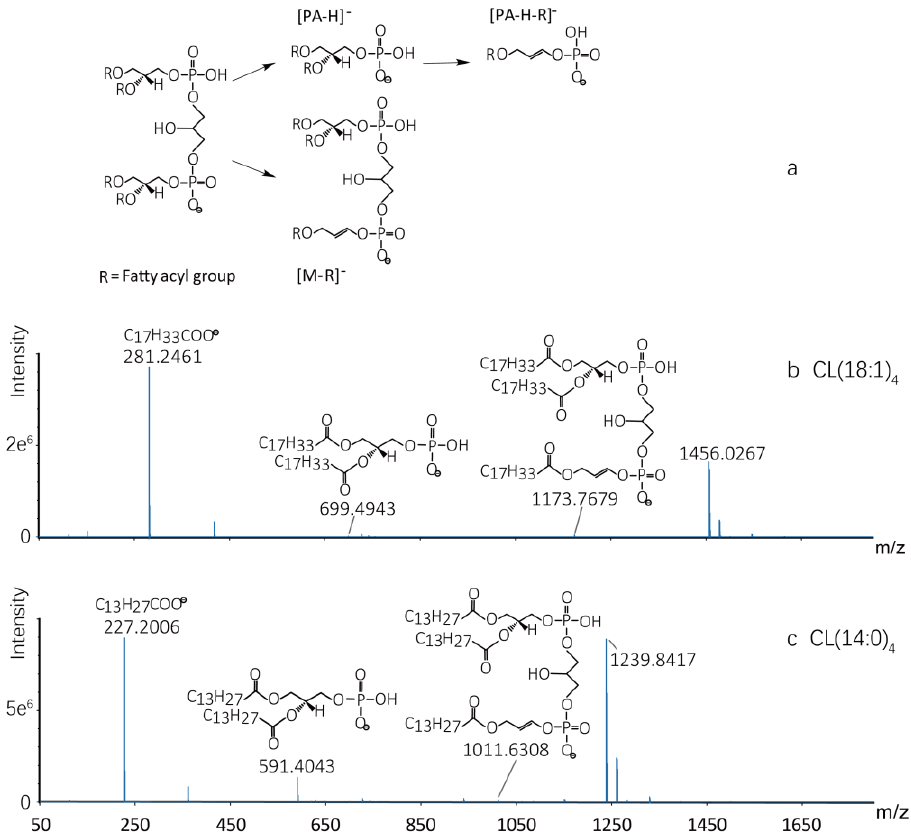
Figure 1. The chemical structure and characteristic product ions of CLs. ( a ) The chemical structures of CLs, consisting of two phospholipid groups, three glycerol groups and four fatty acyl chains. [PA-H] − , [PA-H-R] − and [M-R] − are the major characteristic fragments. ( b ) The chemical structures and characteristic product ions of CL (18:1) 4 . ( c ) The chemical structures and characteristic product ions of CL (14:0)